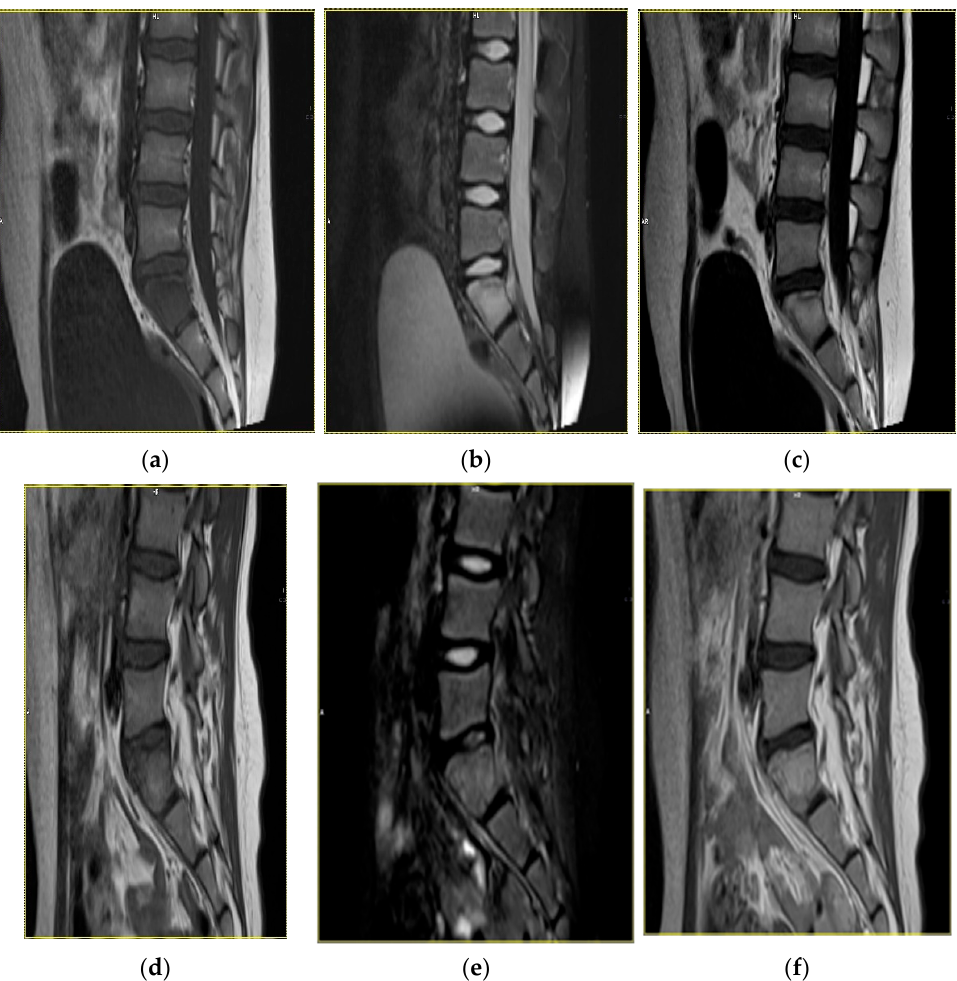
Figure 4. Magnetic resonance images in a 9-year-old female patient with inflammatory lesions within S1 sacral vertebra. Status before treatment: T1-weighted sequence ( a ), T2-weighted sequence ( b ), T1-weighted sequence with contrast enhancement ( c ). Status after an 8-month follow-up, with regression of the inflammatory lesions: T1-weighted sequence ( d ), T2-weighted sequence ( e ), T1-weighted sequence with contrast enhancement ( f ).